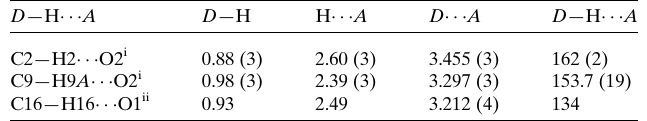
Table 1 Hydrogen-bond geometry (A˚ , (cid:2) ).